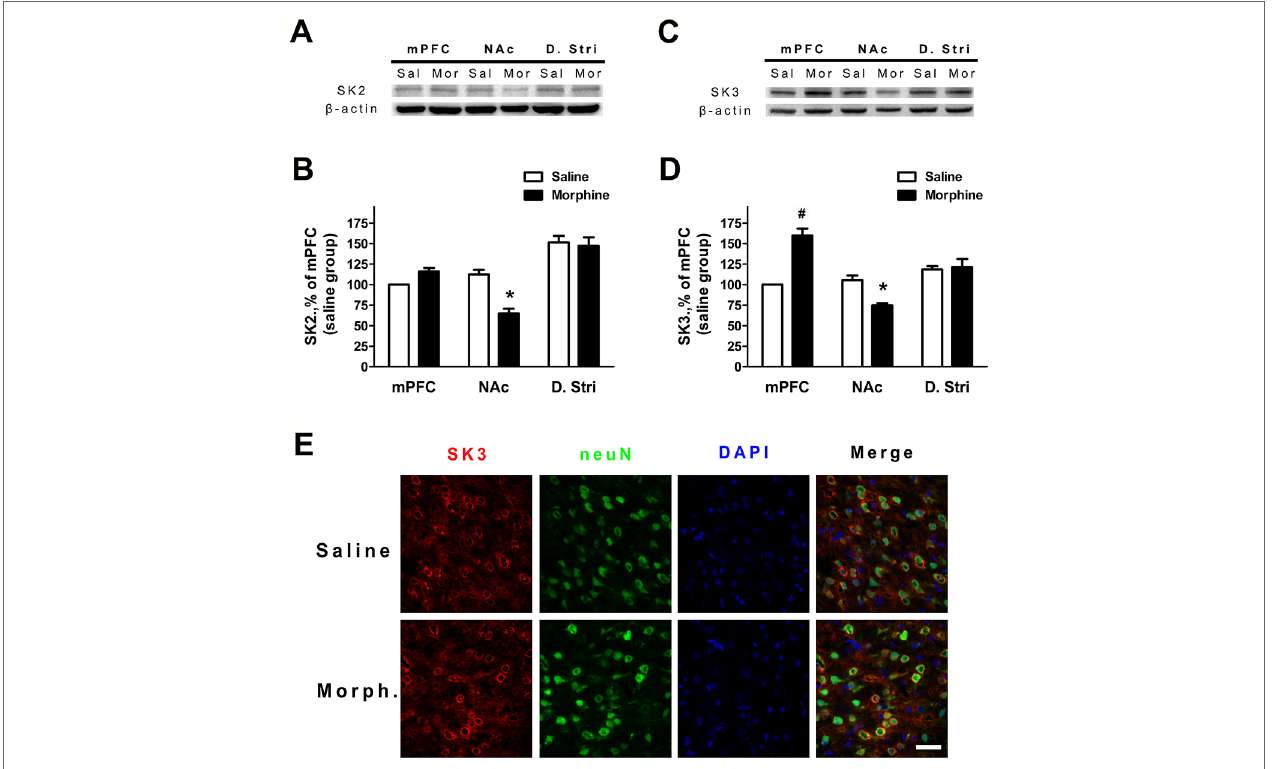
FIGURE 4 | The protein expression of SK2 and SK3 subunits was changed in different brain regions after 3 weeks of morphine withdrawal. (A) Representative Western blots showing the changes of SK2 subunit protein expression in mPFC, NAc, and dorsal striatum after morphine withdrawal. (B) Quantitative analysis of SK2 subunit protein expression in (A) , normalized to β -actin. The data are shown as means ± S.E.M., * p < 0.05 vs. saline. (C) Representative Western blots showing the changes SK3 subunit protein expression in mPFC, NAc, and dorsal striatum after morphine withdrawal. (D) Quantitative analysis of SK3 subunit protein expression in (C) , normalized to β -actin. The data are shown as means ± S.E.M., * p < 0.05 vs. saline. (E) SK3/NeuN/DAPI-positive neurons in the infralimbic (IL) cortex after 3 weeks of morphine withdrawal; scale bar = 50